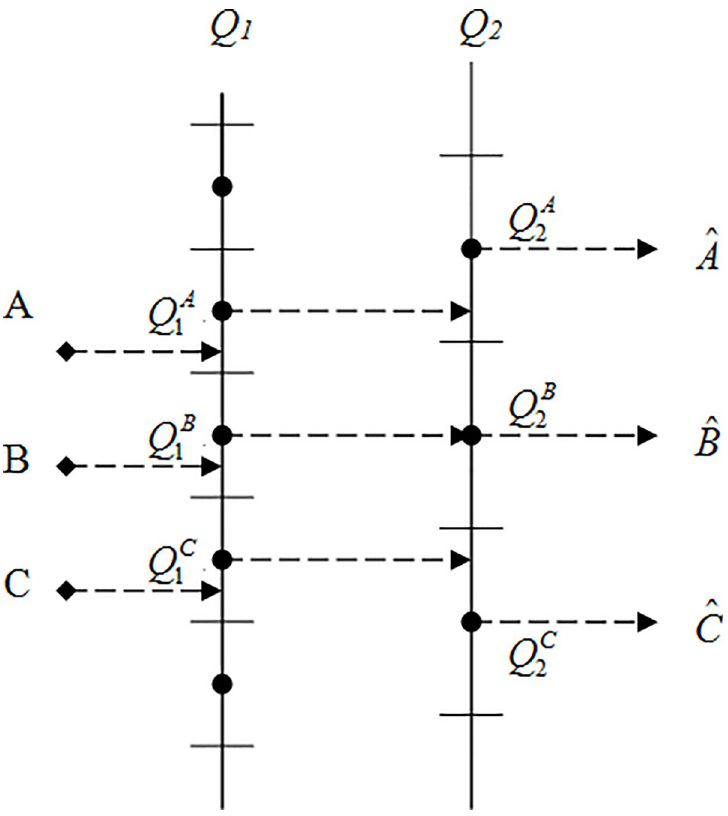
Fig 7. Quantization in pixel domain.